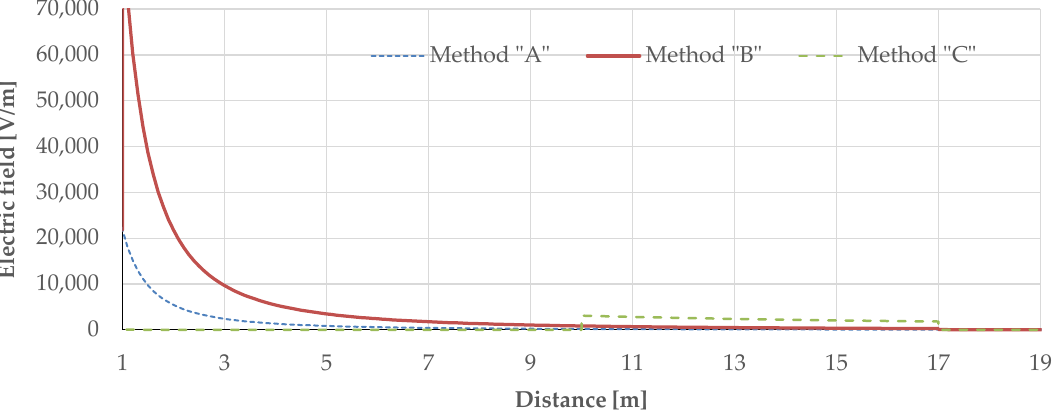
Figure 15. Electric field strength diagram, with respect to distance in the breakwater area ( r 1 = 1 m < r < r 2 = 17 m), with three methods, “A”, “B”and “C”, for the case of Stachtoroi ( θ w = 0.2718 ◦ , θ = 210 ◦ , r 1 = 1.0 m, r 2 = 17.0 m, r 3 = 10.0 m, r ∞ = 150 km, ρ s = 1,000 Ω · m, ρ d = 100 Ω · m).